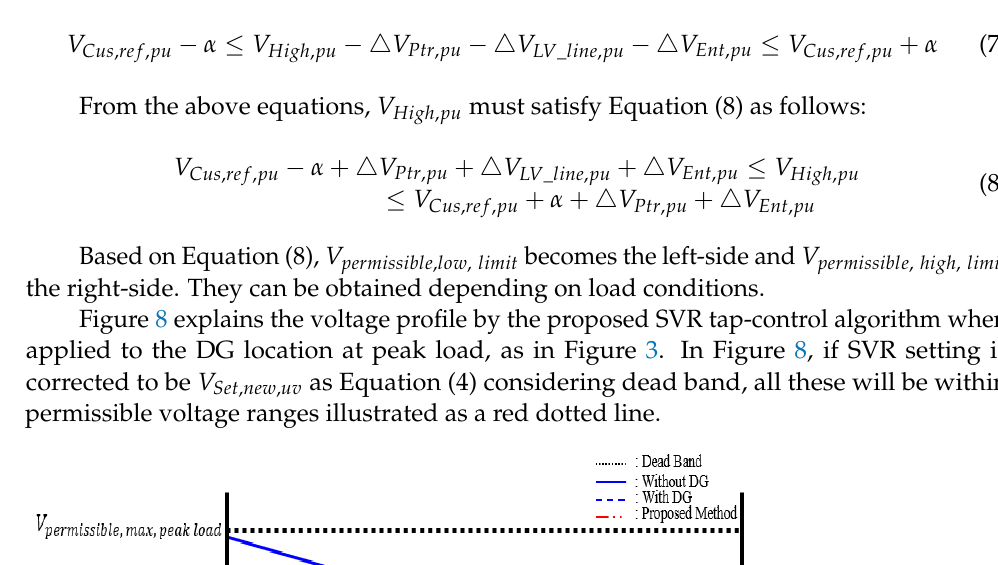
Figure 7. Distribution Line Downstream after SVR.